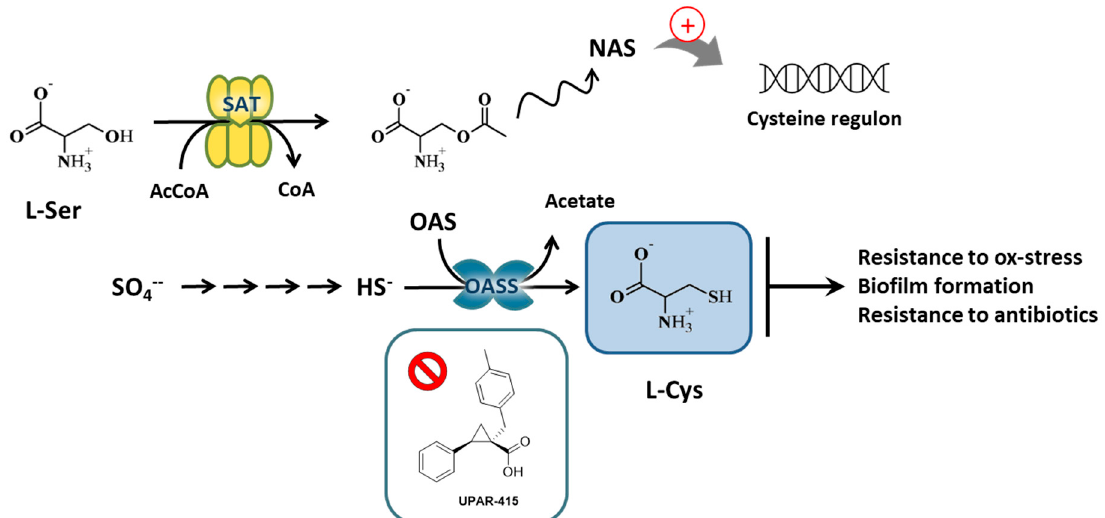
Figure 1. Schematic representation of the reductive sulfate assimilation pathway in Salmonella. Inorganic sulfate is transported inside the cell where it is reduced to bisulfide by a multi-step process. L-serine is activated by O -acetylation by SAT to give the product OAS, which spontaneously tautomerizes to NAS, the inducer of the cysteine regulon. A β -substitution reaction between OAS and HS - , catalyzed by OASS, leads to L-cysteine formation. This amino acid and the pathways of its biosynthesis influence many processes relevant to infection, like resistance to oxidative stress, biofilm formation and antibiotic resistance. UPAR415 is a competitive inhibitor of OASS.